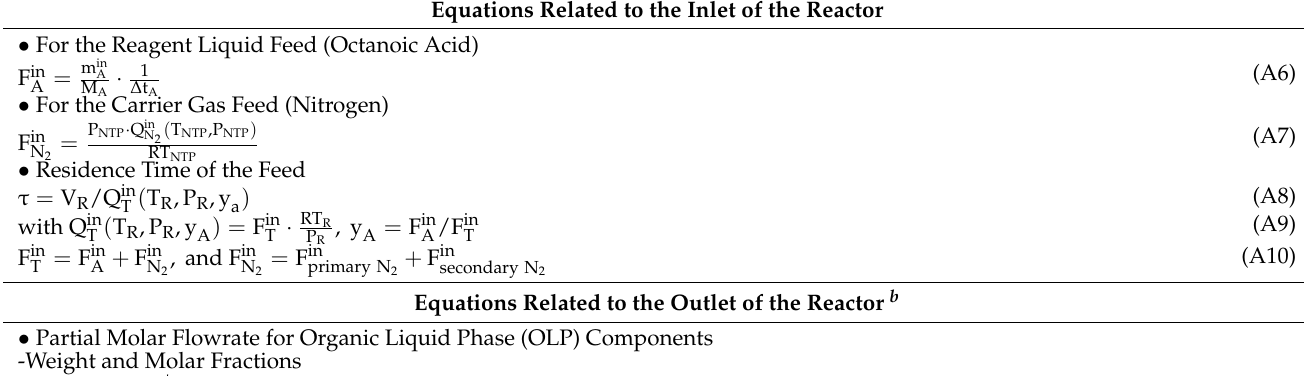
Table A2. General equations related to the C-H-O element mole balances made on the designed experimental setup a . Equations Related to the Inlet of the